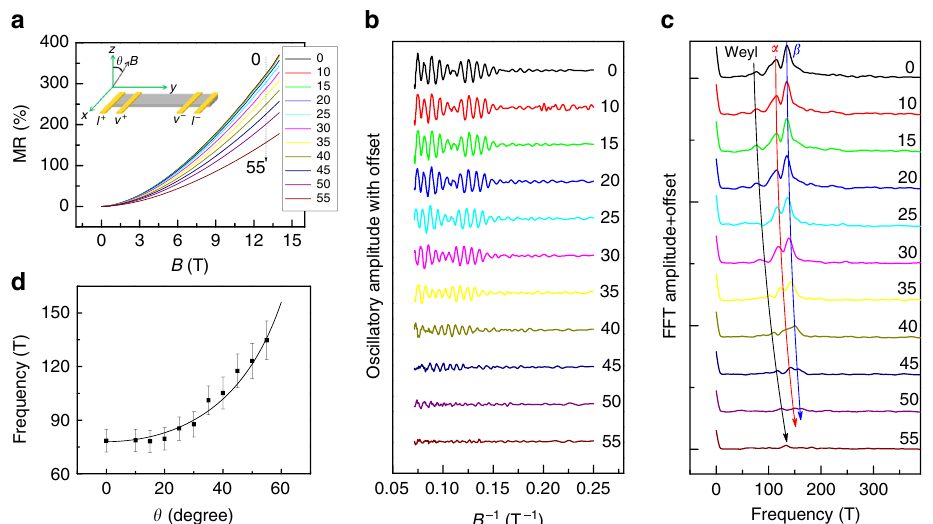
Fig. 2 Angle-dependent quantum oscillations. a The MR data from b -axis ribbon obtained at different angles and T = 2 K. b The d 2 R /d B 2 data obtained from a clearly shows quantum oscillations. c The evolution of quantum frequency in FFT spectra obtained from b as the angle increases. The arrow indicates the evolution of the peaks. d Angle dependence of extracted Weyl orbit frequency. It shows a cos (cid:4) 1 θ dependence (solid line), indicating a 2D surface state. The error bar of 20%, including standard instrument error and FFT frequency spacing estimate, was added into the angular dependence of